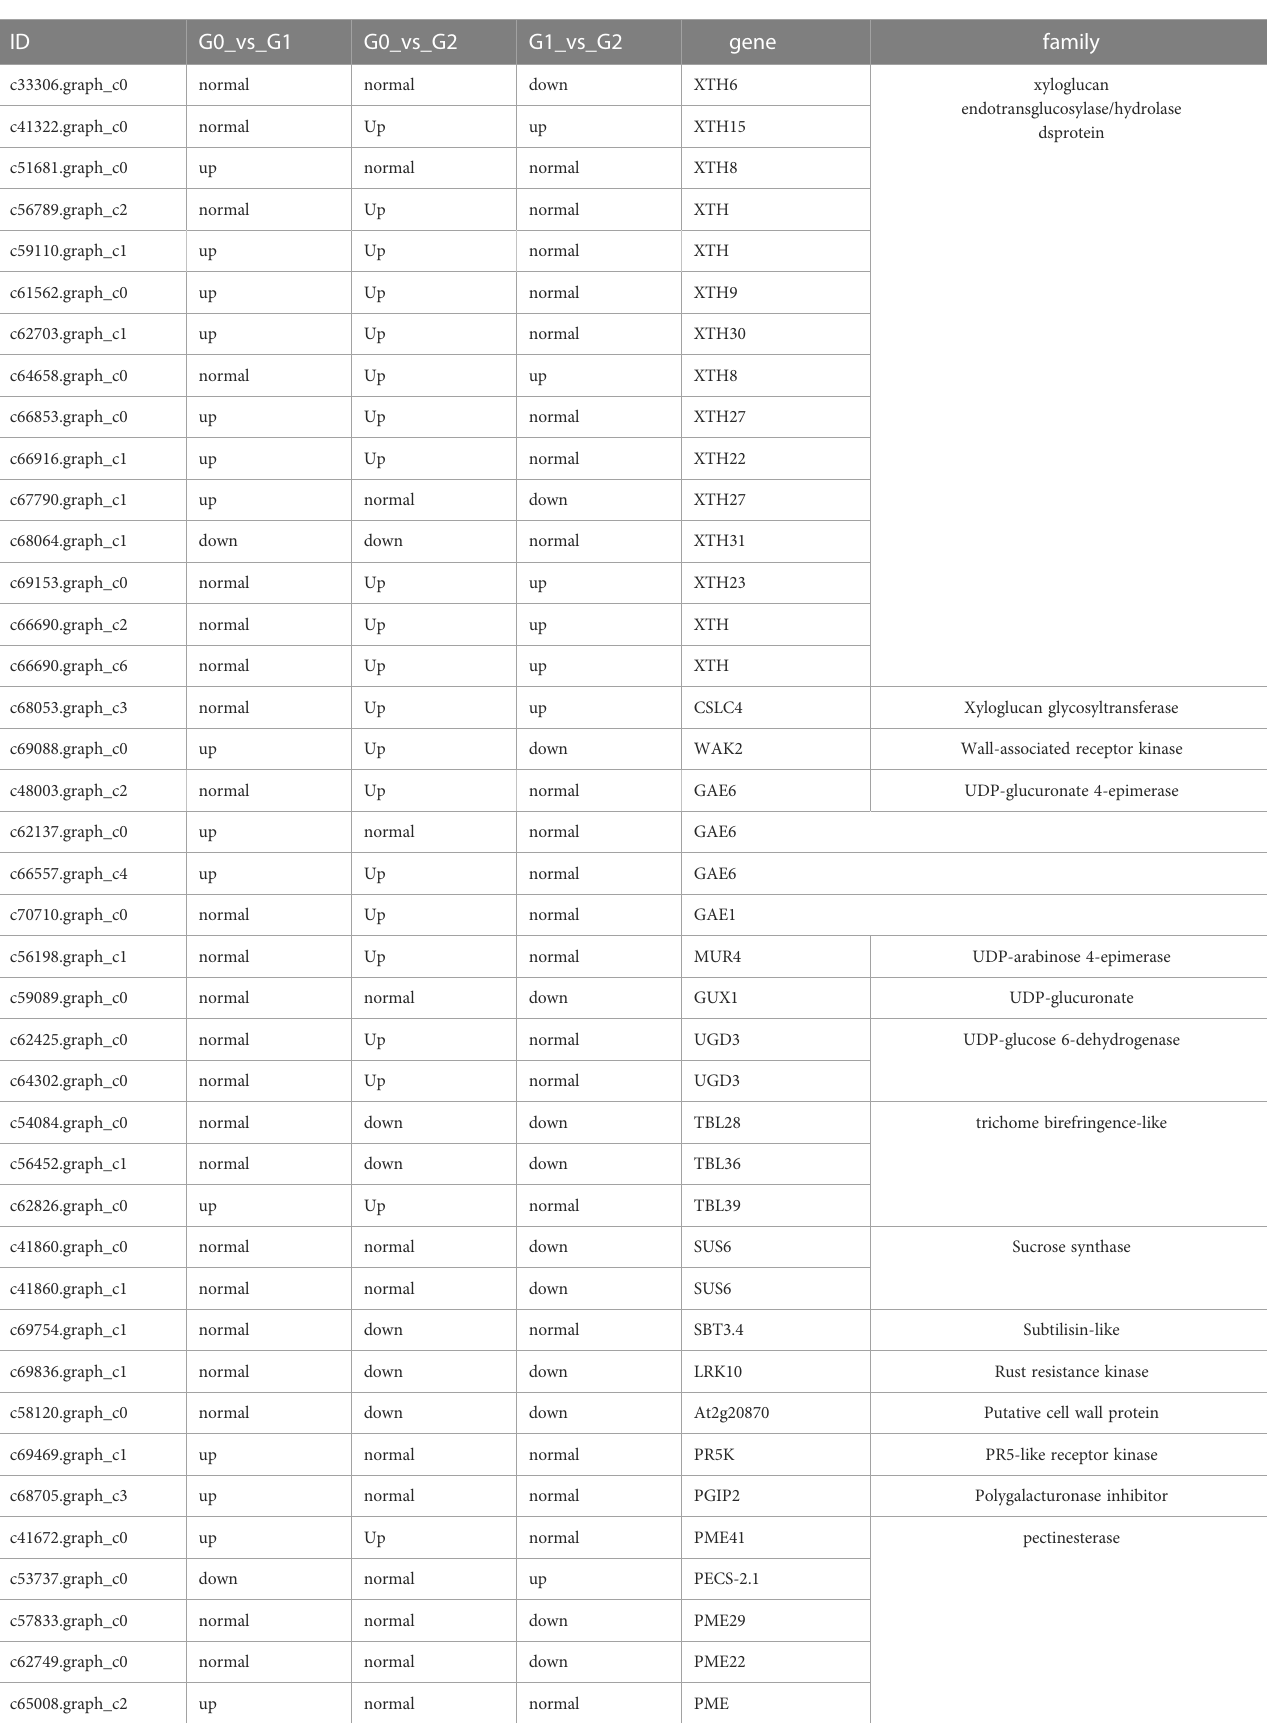
TABLE 7 Cell wall biosynthesis/modi fi cation related